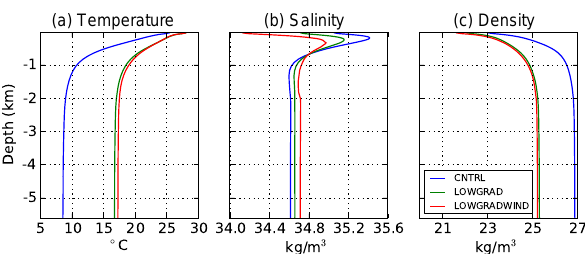
Figure 5. Vertical profiles of global horizontal mean in ocean of (a) temperature ( ◦ C), (b) salinity (kgm − 3 ) and (c) ocean potential density (kgm − 3 ) for the control case CNTRL (blue), the low tem- perature gradient case LOWGRAD (green), and the low tempera- ture and weak wind case LOWGRADWIND (red).